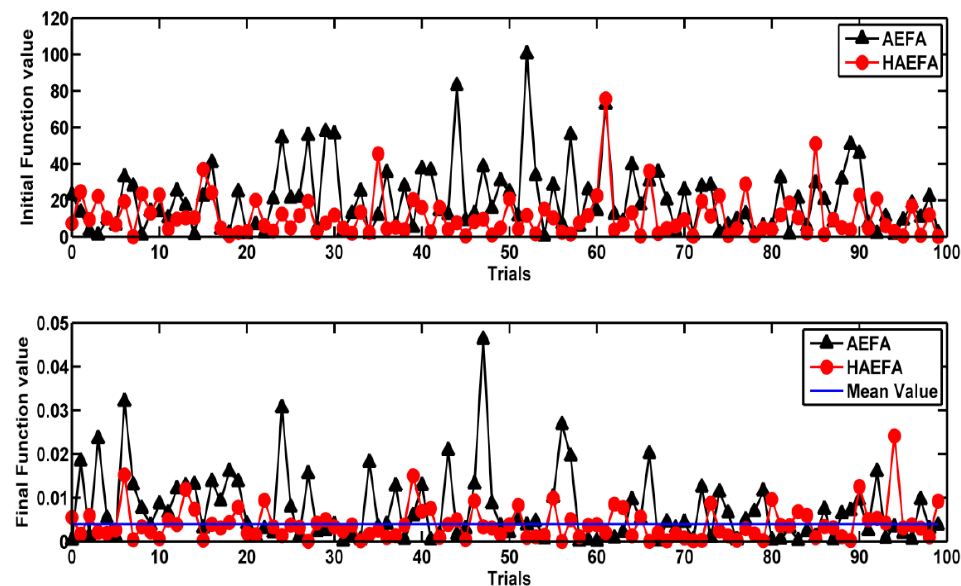
Figure 7. Sphere function objective value at initial and final instant using AEFA and HAEFA methods for 100 trials.